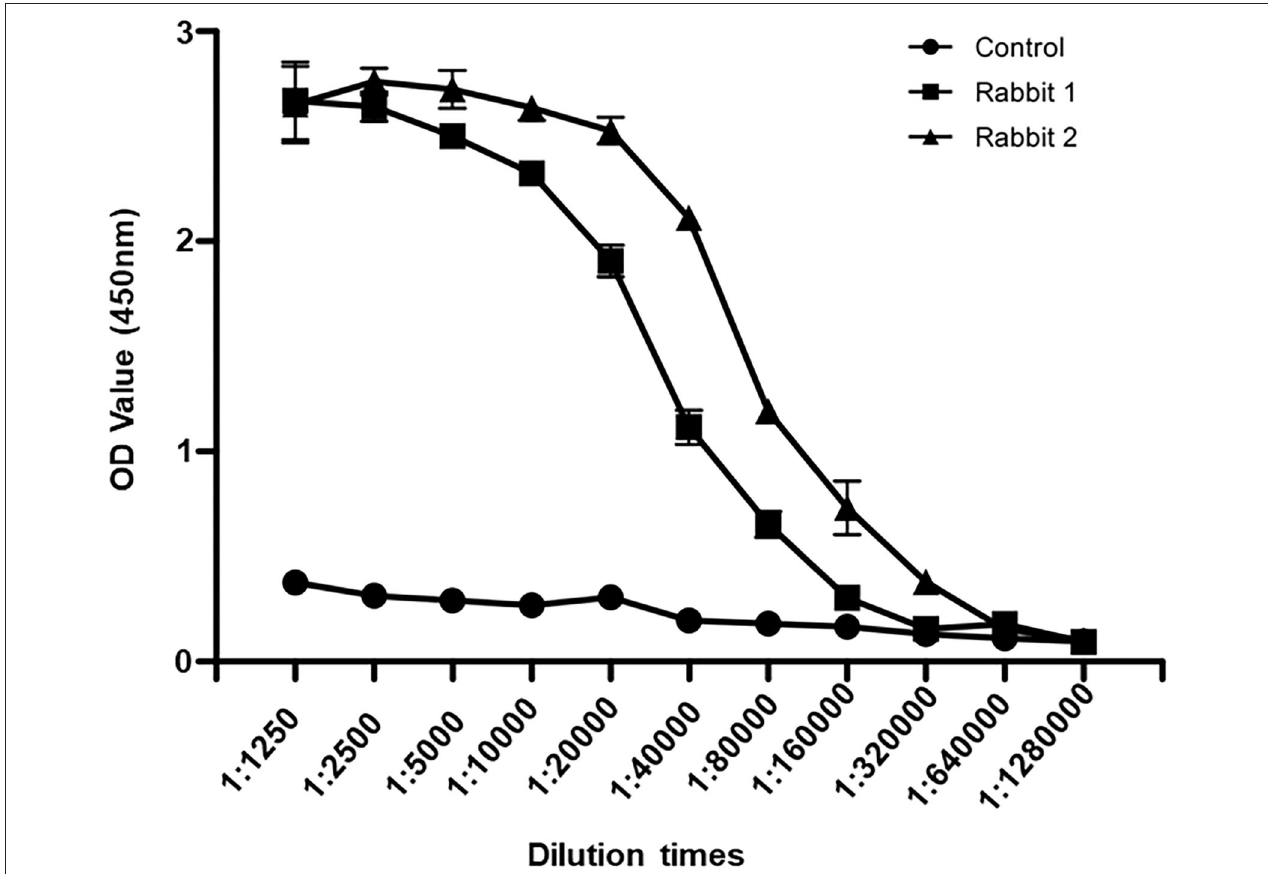
FIGURE 4 | Antibody titer detection by ELISA. Sera from rabbit one, rabbit two, and healthy rabbit were diluted to 1:1250, 1:2500, 1:5000, 1:10000, 1:20000, 1:40000, 1:80000, 1:160000, 1:320000, 1:640000, and 1:1280000. The values of OD450 were